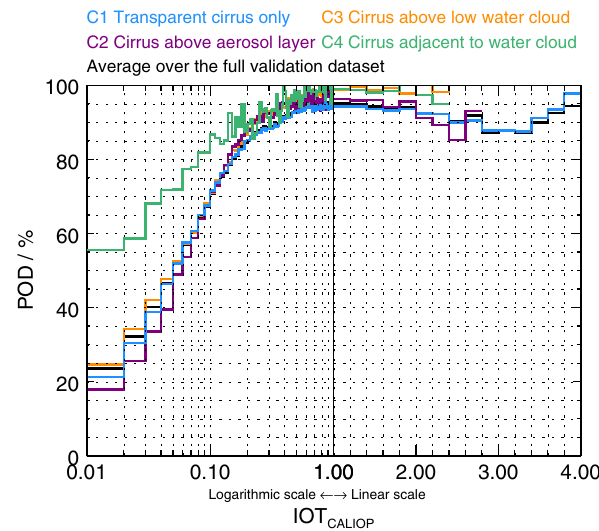
Figure 6. The cirrus POD of CiPS as a function of the IOT retrieved by CALIOP for the vertical cloud–aerosol structure classes C1–C4 along with the average POD over the full collocation